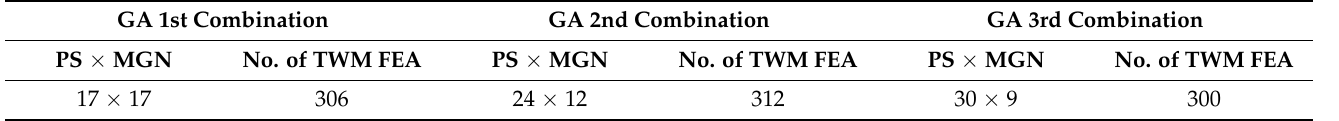
Figure 12. Comparison between the basic and optimized APMMs with 20 stator segments and N i = 3, 4. ( a ) Cogging torque waveforms. ( b ) Cogging torque harmonic spectra. Table 6. GA population size and maximum generations number set for the direct approach.